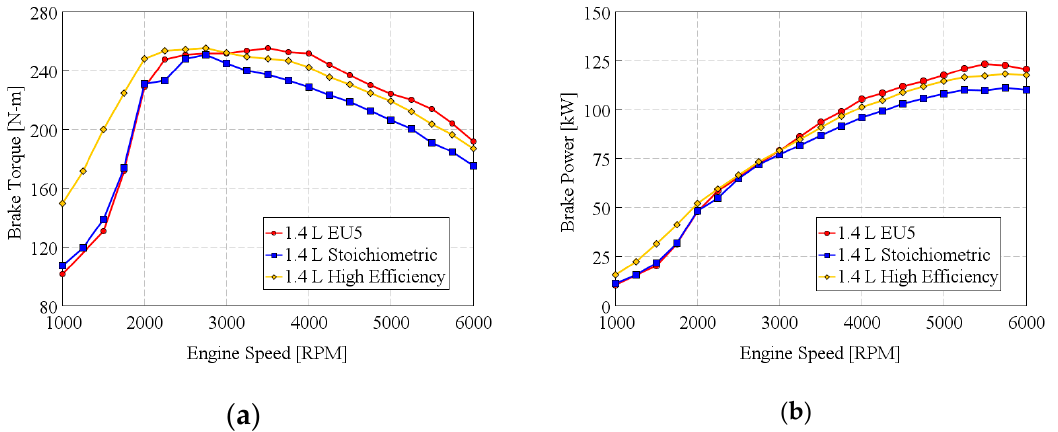
Figure 5. Full load performance for the proposed engine concepts: ( a ) brake torque; ( b ) brake power.